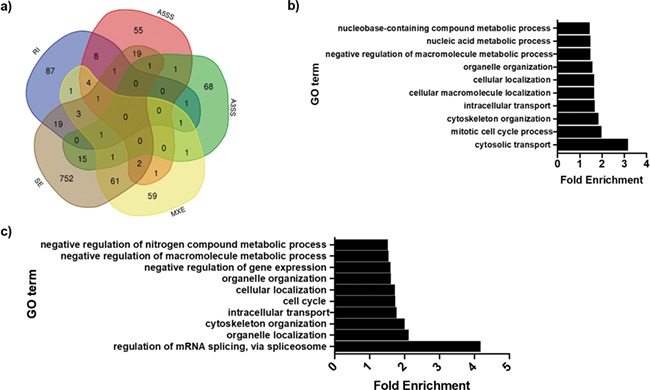
Global mis-splicing in EFTUD2-knockdown cells. (a) Venn diagram of numbers of genes displaying multiple forms of altered splicing in EFTUD2-knockdown cells. SE = skipped exon, RI = retained intron, MXE = mutually exclusive exons, A5SS = alternative 5′ splice site use, A3SS = alternative 3′ splice site use. (b) Top 10 enriched GO terms for biological processes associated with all genes displaying significantly altered splicing in EFTUD2-knockdown cells, obtained using the PANTHER Overrepresentation Test (release March 8, 2019, annotation data set GO Biological Processes Complete, Fisher’s Exact test with Bonferroni correction). (c) Top 10 enriched GO terms for biological processes associated with all genes displaying significantly altered exon skipping events in EFTUD2-knockdown cells, obtained using the PANTHER Overrepresentation Test release (March 8, 2019, annotation data set GO Biological Processes Complete, Fisher’s Exact test with Bonferroni correction).